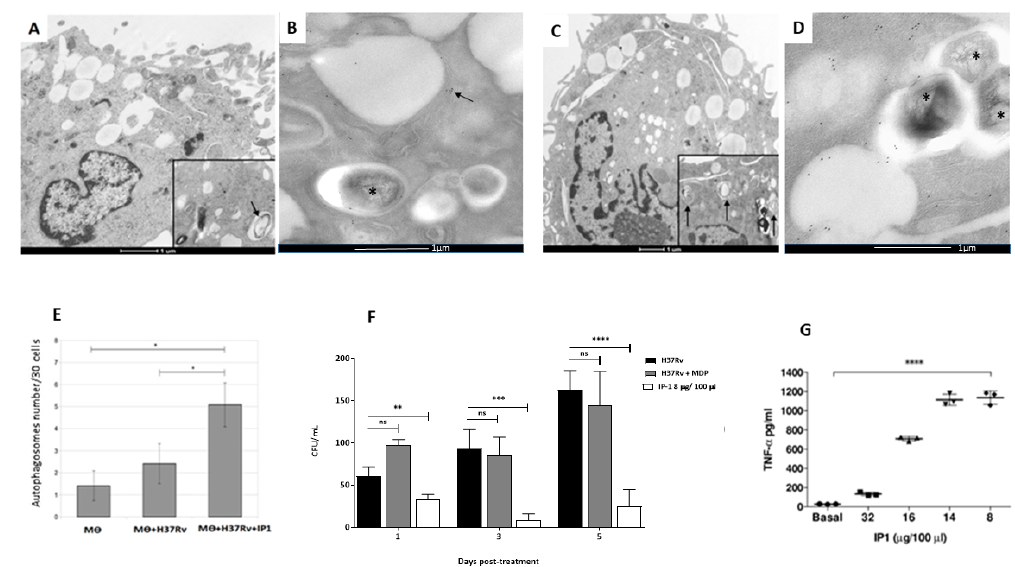
Figure 5. E ff ect of IP-1 on macrophages infected in-vitro with M. tuberculosis strain H37Rv. Representative electron microscopy micrographs of: ( A ) macrophage after one hour infection showing a phagocytosed bacteria and in the inset occasional double membrane vacuoles that correspond to autophagosomes (arrow). ( B ) Subcellular detection of autophagosomes by immunolabeling with specific antibodies against LC3, macrophage after 24 h of infection showing a phagosome with bacteria (asterisk) near to vacuoles / lysosomes surrounded by LC-3 detected by gold labeled antibodies (black dots, arrow). ( C ) Infected macrophage and incubated with IP-1 showing bacterial debris and in the inset several autophagosomes (arrows). ( D ) Infected macrophage incubated with LC-3 showing bacteria into phagosomes (asterisks) near to several LC-3 immunogold labeled vacuoles / lysosomes (black dots). ( E ) The morphometric study confirms significantly more autophagosomes ( y -axis) in infected macrophages incubated with IP-1. ( F ) Determination of intracellular bacillary loads by colony forming units counts (CFU) in infected macrophages with mycobacteria strain H37Rv, after one, three and five days of incubation with MDP (muramil dipeptide control) or with 16 µ g / 100 µ L of IP-1; all the studied times showed significant decrease of live bacillary counts. ( G ) Macrophages were infected with mycobacteria strain H37Rv, and after 24 h of incubation with the indicated concentration of IP-1 the supernatants were collected and used to determine TNF α by ELISA, low IP-1 concentrations (8 and 16 µ g / 100 µ L) induced significant amount of TNF α , while larger IP-1 concentration (32 µ g / 100 µ L) reduced its production. Each symbol represents one independent experiment. Each symbol (Triangles, squares, circles) represents one independent experiment. Asterisk represents statistical significance (* p < 0.05, ** p < 0.003, *** p < 0.002, **** p < 0.0005). ns: not